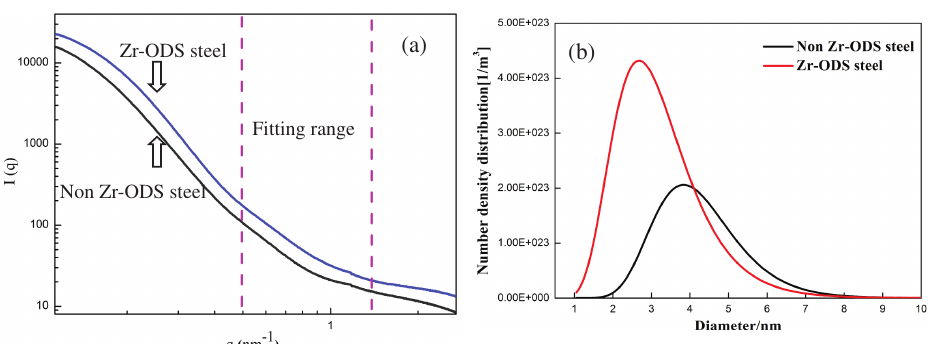
Figure 5: EDS spectrum of the oxides retrieved in a carbon replica from the ODS steels (a) non Zr-ODS steel (b) Zr-ODS steel.